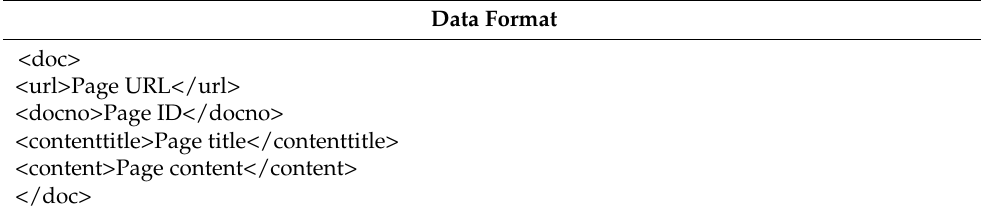
Table 1. Sample data of SoHu